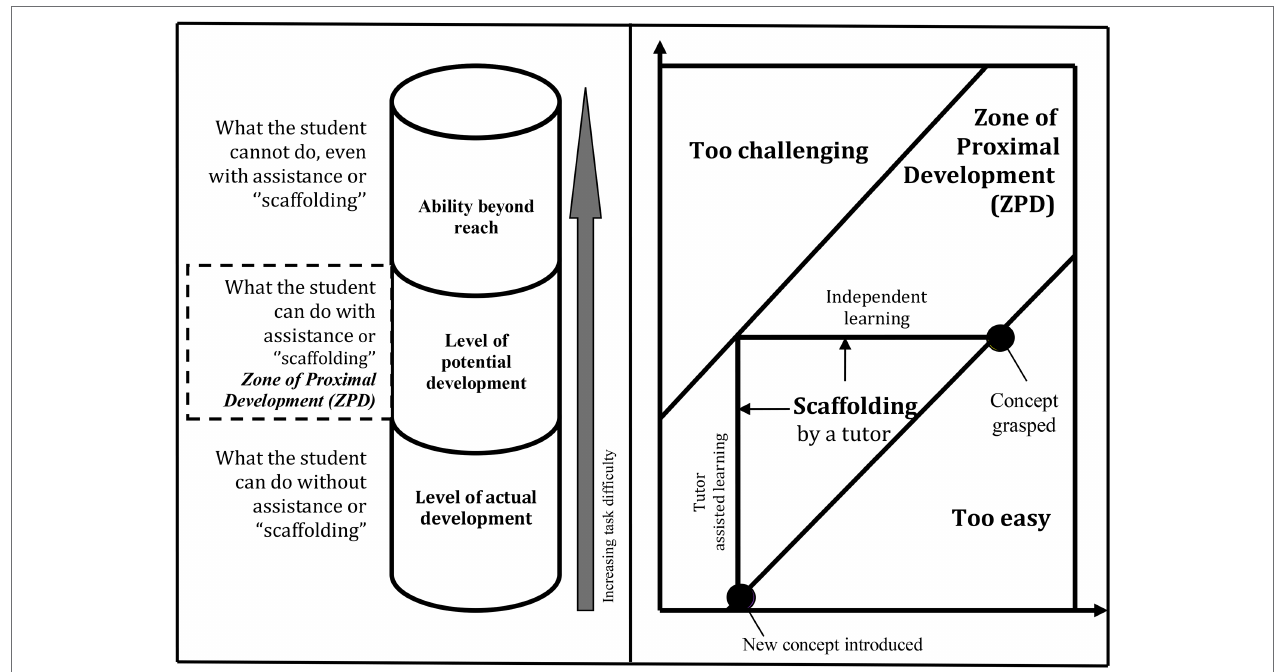
FIGURE 1 | The zone of proximal development and scaffolding. Source: Modified from Vadnais (2015) and Grahame